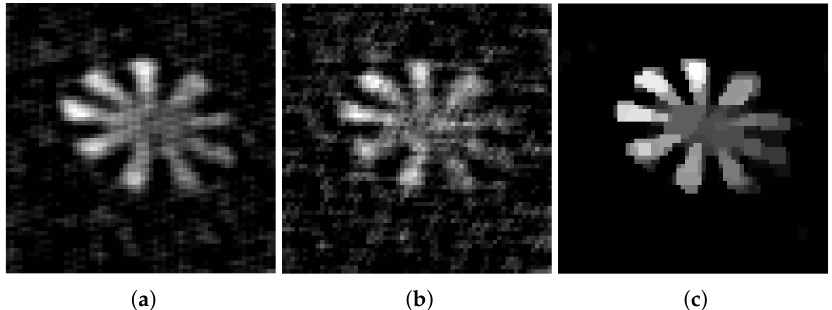
Figure 6. In the case of the sampling rate is 0.15, the image measured by adaptive measurement matrix reconstructed by OMP ( a ), IHT ( b ), and TVAL3 ( c ) algorithms. The resolution of the image is all 64 × 64.